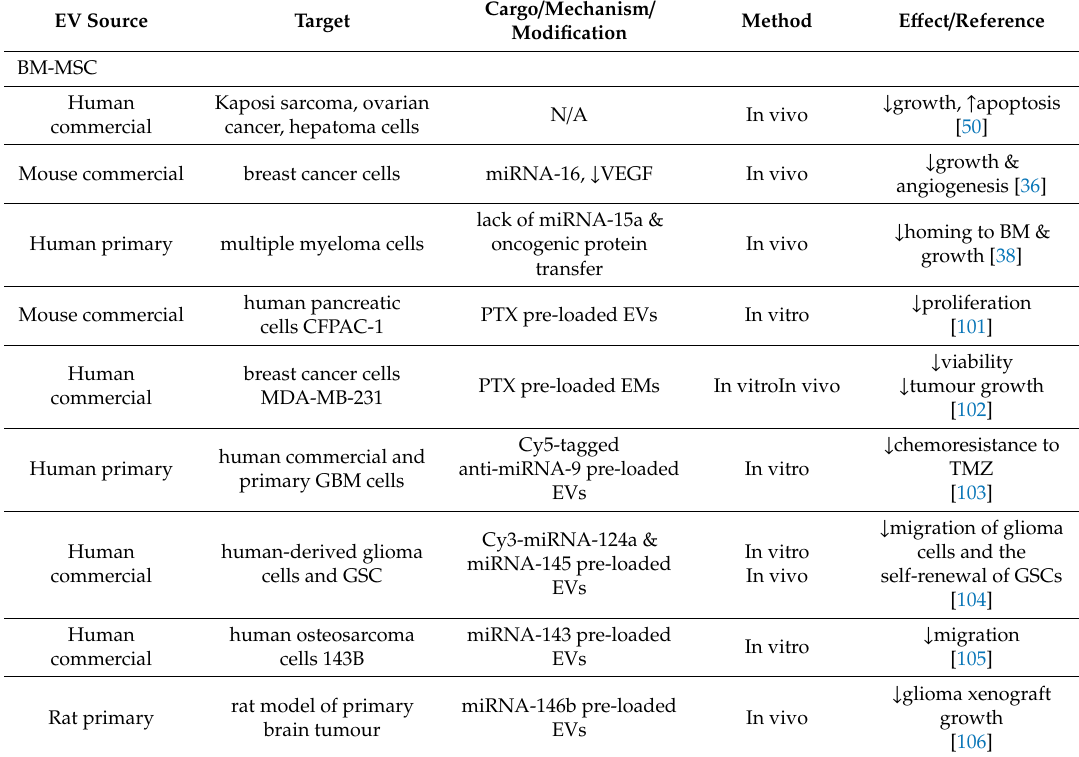
Table 2. Summary of anti-cancer e ff ects of native, modified, and engineered adult SC